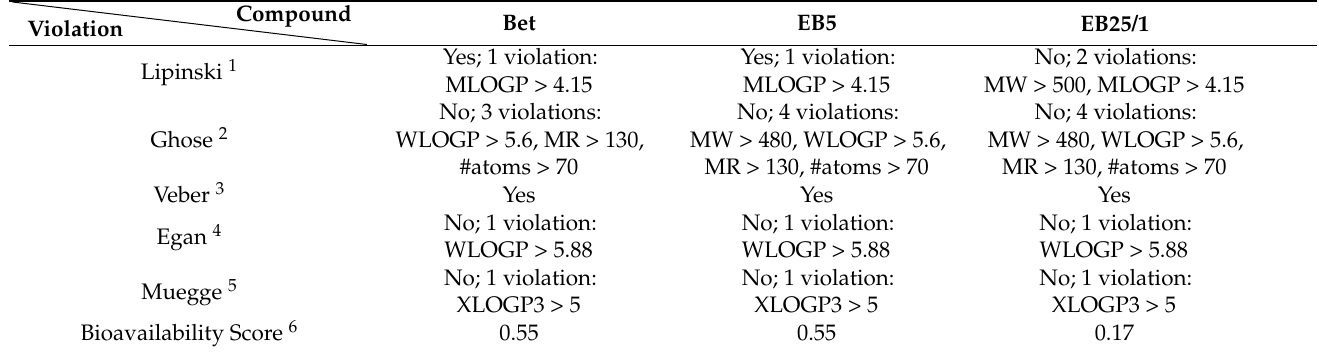
Table 3. Druglikeness of Bet and ASBDs—in silico analysis. Compound Violation Lipinski